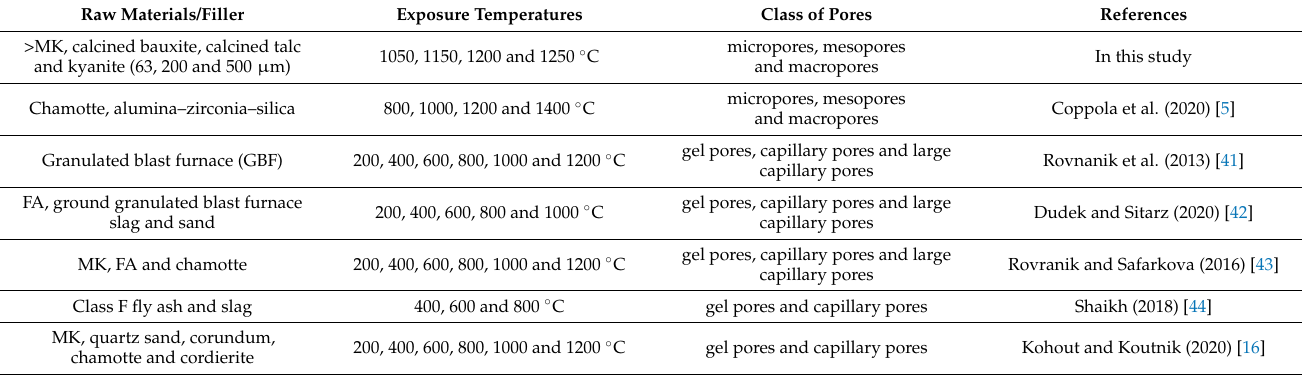
Table 4. Type of pores of different geopolymers after exposure to high-temperatures (literature results). Raw